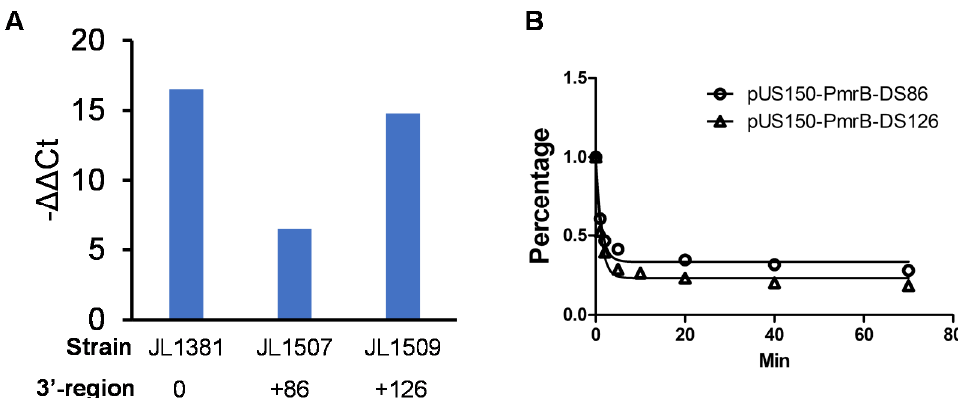
Figure 2. The effects of pmrB downstream region on the transcription and stability of pmrB . ( A ) The effect of pmrB downstream region on pmrB mRNA levels. The cloned pmrB of BL21 origin in JL1381, JL1507 and JL1509 includes 0, 86 and 126 bp downstream regions, respectively (indicated below strain name). Quantitative RT-PCR was performed to assess transcription level of pmrB. The JL1088 strain that carries parent plasmid pZE21 was used as a control. The pmrB mRNA levels in JL1381, JL1507 and JL1509 were compared with that in JL1088 (expressed as −ΔΔCt). ( B ) Decay curves of pmrB mRNA in JL1507 (TOP10/pUS150-PmrB-DS86) and JL1509 (TOP10/pUS150-PmrB-DS126) after transcriptional arrest by rifampicin. The mRNA level was measured by quantitative RT-PCR (detailed in Materials and Methods ). The Y axis represents the ratio (percentage) of quantities of pmrB mRNA at each time point relative to that at the 0 min time point. Three independent experiments were performed. Data points are the mean value from measurements of triplicate cultures in one representative experiment, and fit with one-phase decay curves to calculate the mRNA half-life.